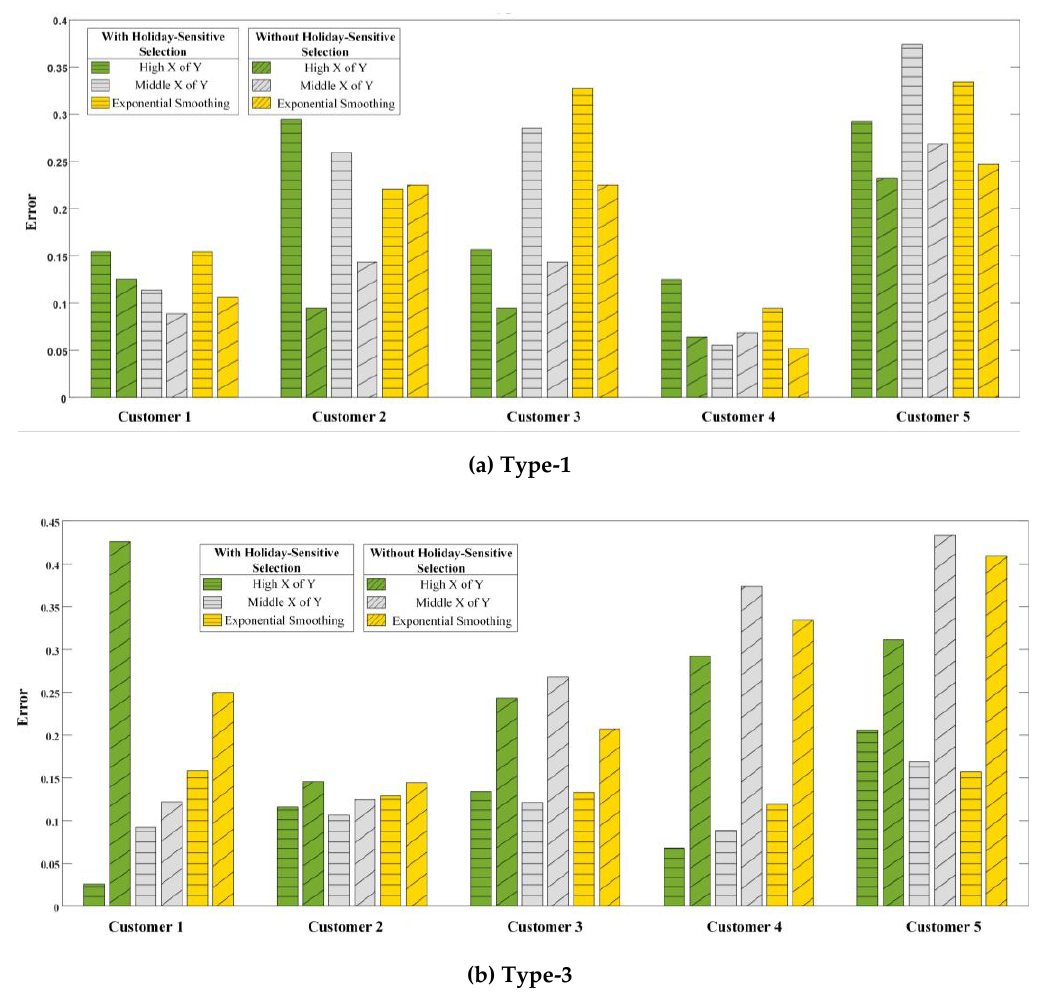
Figure 11. The contrast of the three methods considering holiday sensitivity or not.